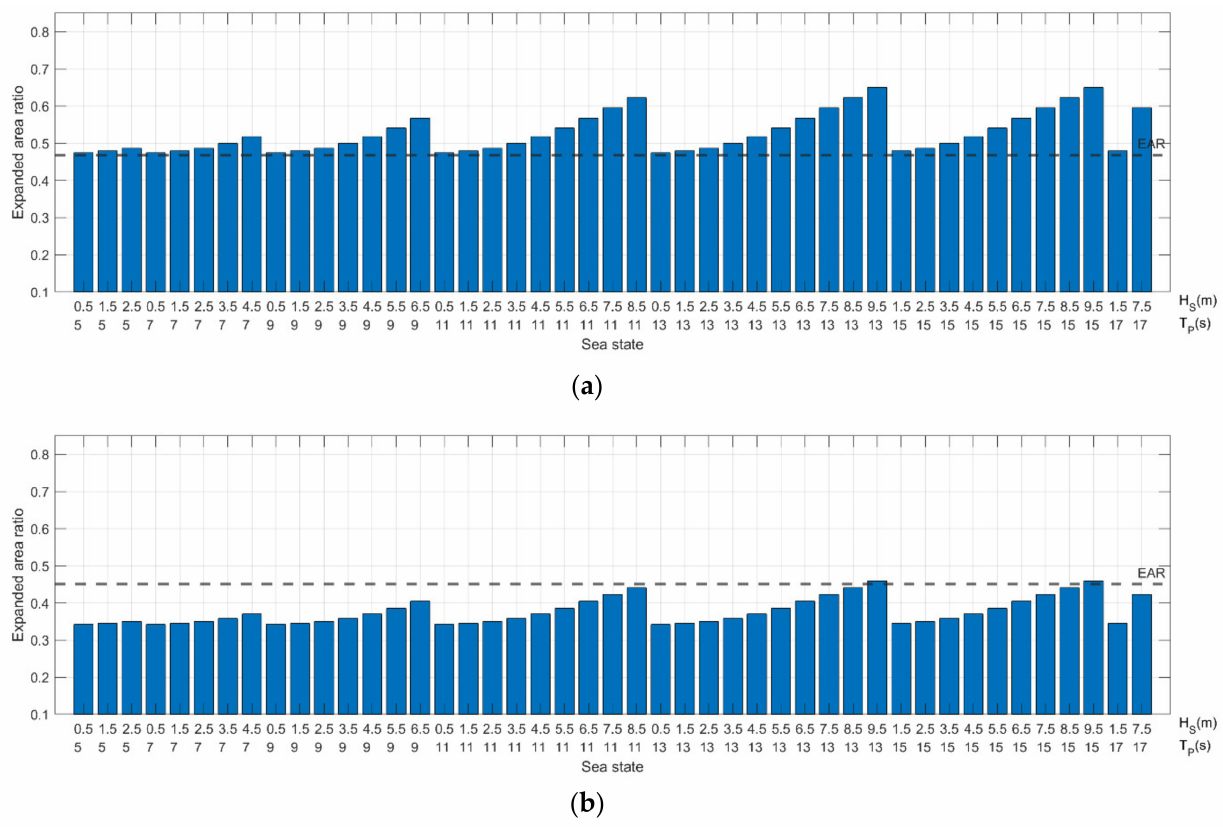
Figure 8. Variation of the minimum EAR for different sea states. ( a ) no cup, ( b ) heavy